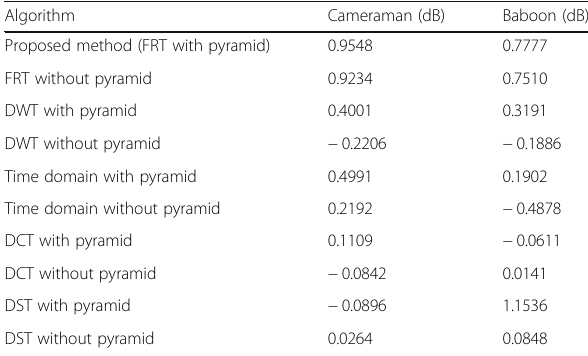
Table 4 NCC of overall separation performances on image mixtures